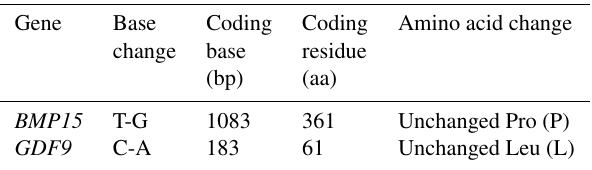
Table 2. The novel single nucleotide polymorphism in BMP15 and GDF9 within the Markhoz.